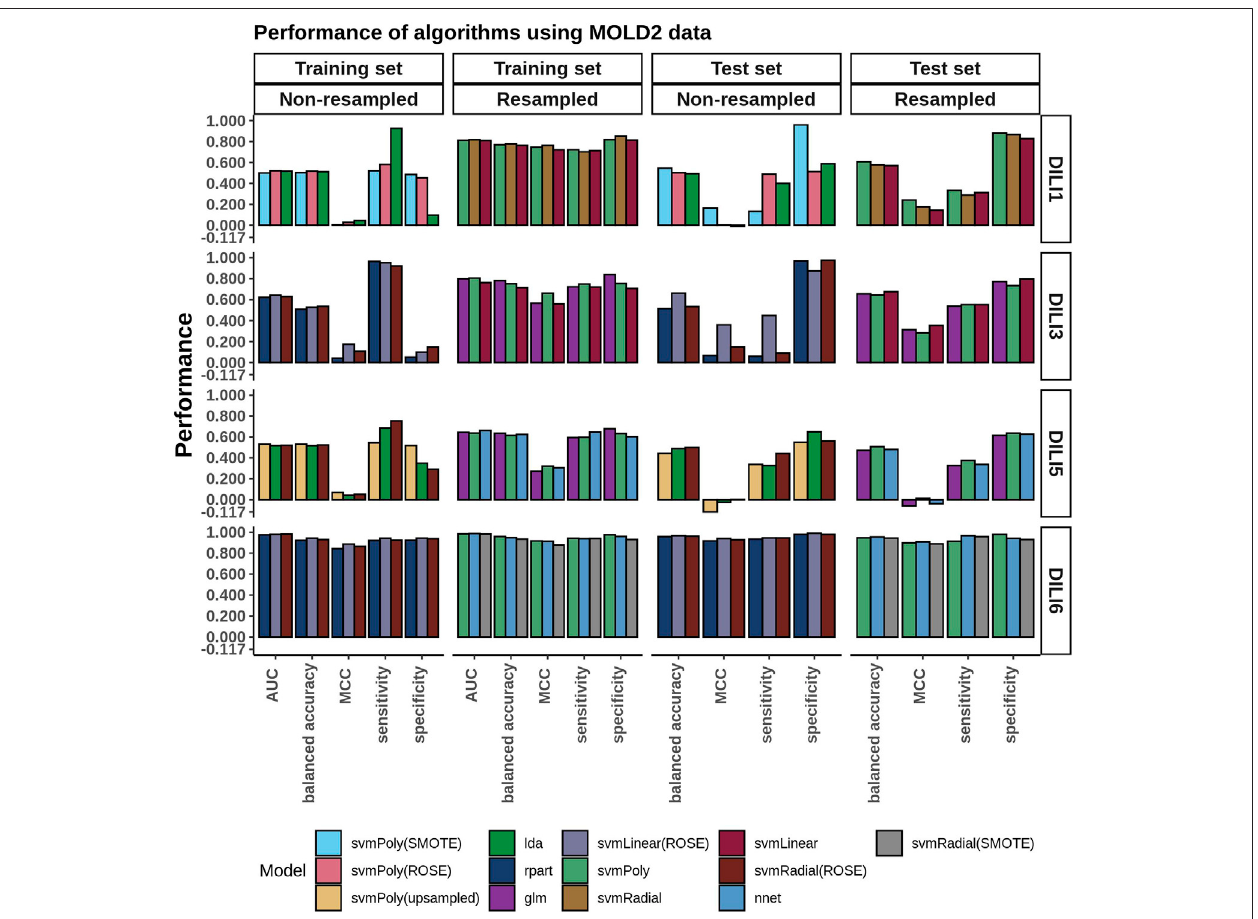
FIGURE5| MOLD2ModelPerformance.ThechemicalstructuralinformationfromMOLD2wasimbalancedbetweenDILIpositiveandnegativesamples.Predictive modelswereevaluatedonboththeunbalancedandresampled/balanceddatasets.Thethreebest-performingmodelsforeachDILItype,basedonAUCandresampling methods, are depicted in the bar